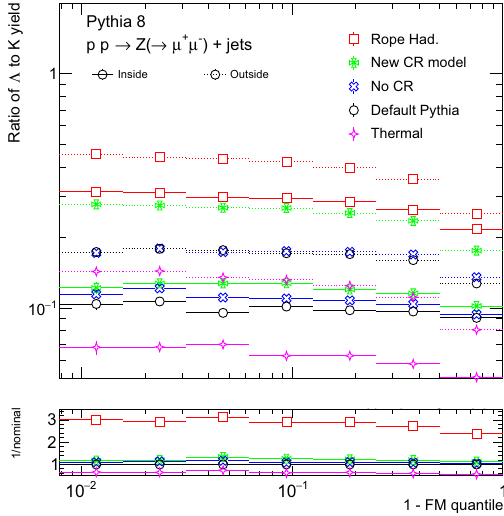
of the x -axis correspond to extreme multiplicities; the rightmost bin captures events with multiplicities at or below the median FM